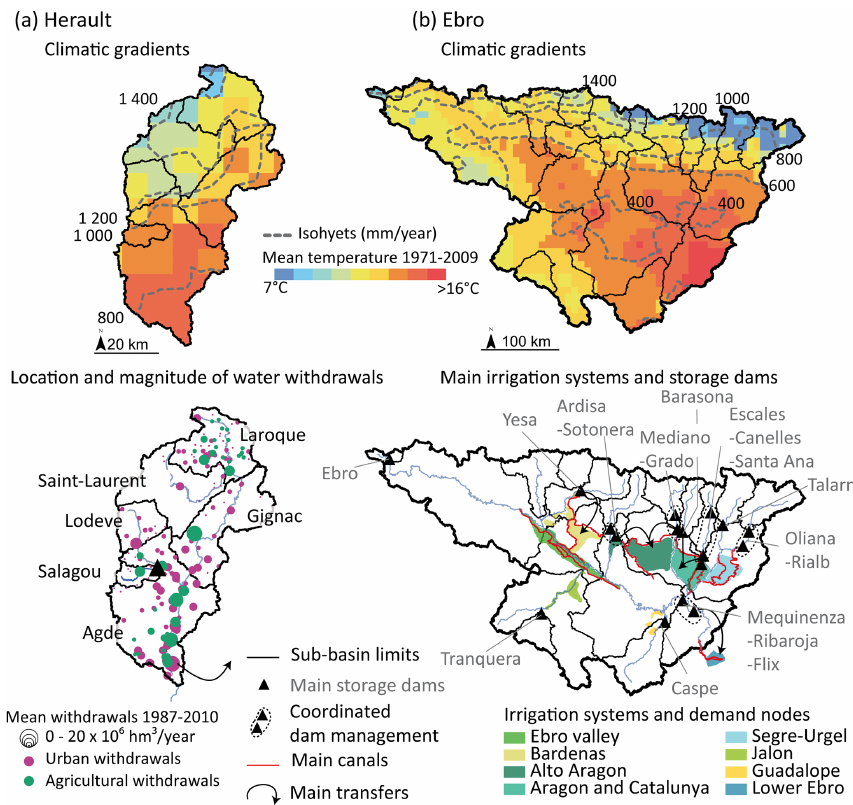
Figure 3. Maps of the main physical and human spatial characteristics of the two basins: (a) 6 sections were selected for simulation of water resources and water demand nodes in the Hérault Basin; (b) 20 sections for simulation of water resources and 8 demand nodes that matched the main irrigation systems were selected in the Ebro Basin.